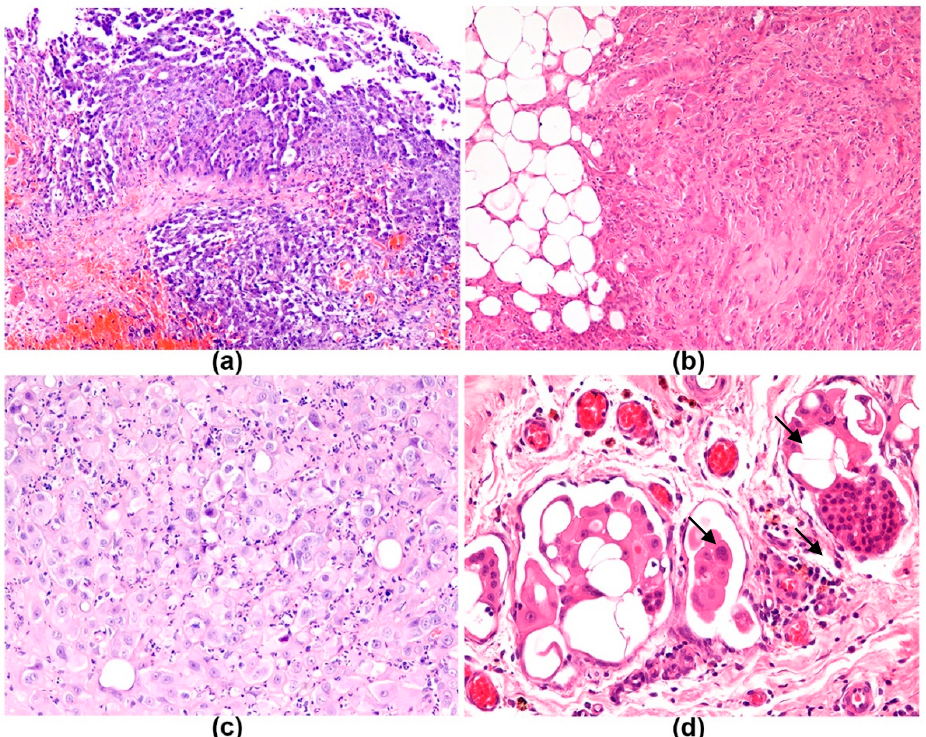
Figure 2. Mesothelioma, dog, H&E. ( a ) Papillary pattern of epithelioid mesothelioma. Thin papillae are visible, 100×. ( b ) Desmoplastic pattern of mesothelioma. Islands and cords of atypical polygonal cells are supported by abundant desmoplastic stroma, 200×. ( c ) Deciduoid mesothelioma. Large cells with abundant glassy eosinophilic cytoplasm, central nucleus and prominent nucleolus are present. ( d ) Solid mesothelioma. Multiple neoplastic emboli in lymphatic vessels (arrows), 400×. Comparing IP and PM cases, the histological features of edema ( p = 0.004, R = 0.53 Spearman test), granulation tissue ( p = 0.02, R = 0.42), macrophages in the visceral/super- ficial pericardial layer ( p = 0.04 R = 0.38) and fibrin ( p = 0.003 R = 0.53) significantly corre- lated with a diagnosis of mesothelioma.